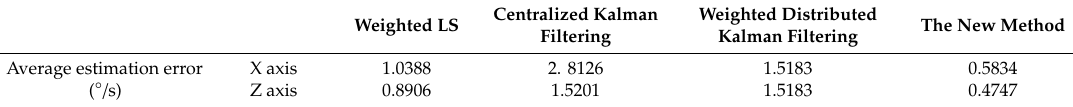
Figure 14. The fusion results for the case of outliers and the constant drift fault. ( a ) X Axis; ( b ) Z Axis. Table 6. The details of fusion signal error for the outlier